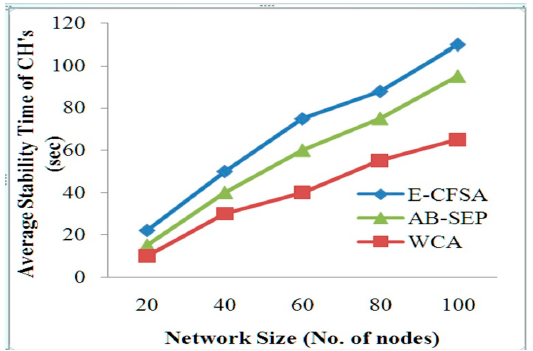
Figure 17. Graph Average Stability Time of CHs Vs. Number of nodes.